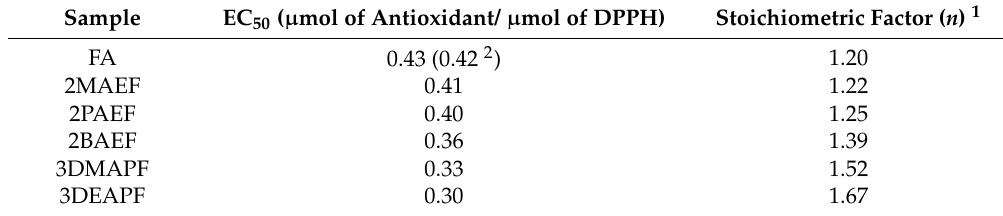
Table 3. Stoichiometric factor of FA and PILs calculated from the EC 50 value. Sample EC 50 ( µ mol of Antioxidant/ µ mol of